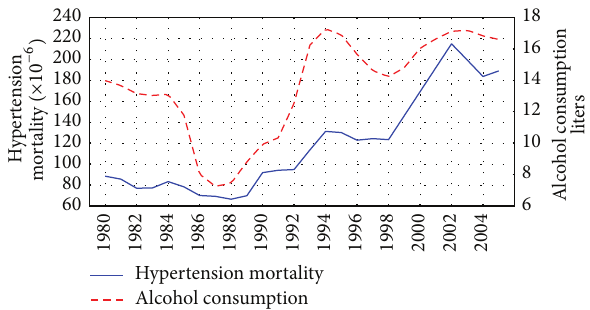
Figure 2: Trends in female HTN mortality rate and alcohol consumption per capita in Russia between 1980 and 2005.